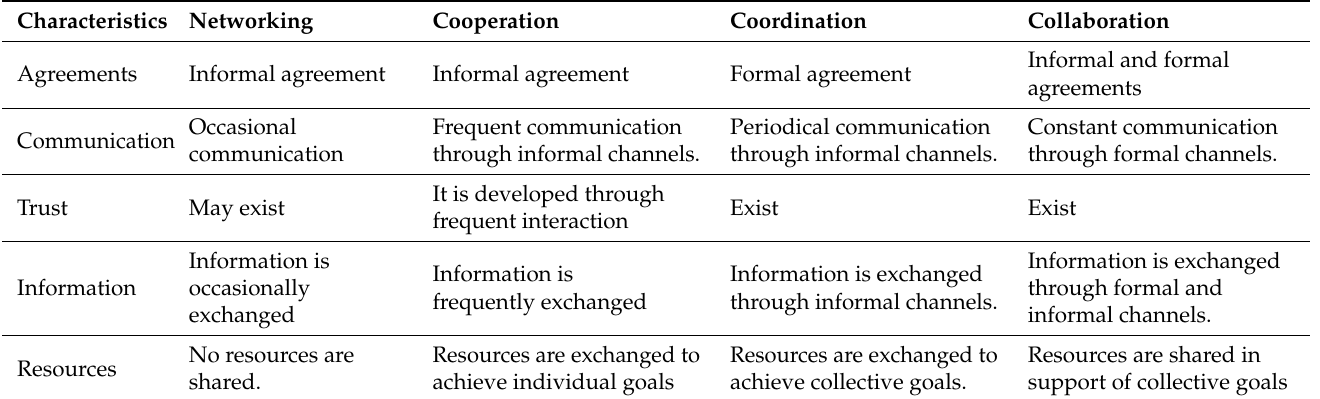
Table 1. Type of working interactions and their characteristics (source: Avram [37]; Chedid et al. [38]; Frey et al. [36]; Keast et al. [35]; Keast et al. [39]; Mayer and Kenter [40]; McNamara [28]; Morris and Miller-Stevens